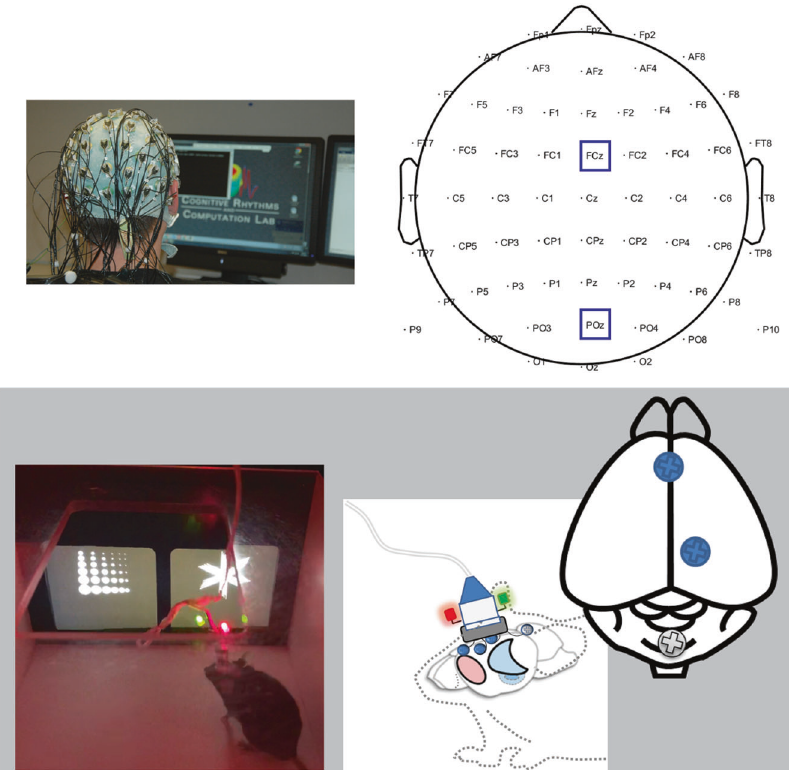
Fig. 1 Schematic electroencephalograph (EEG) recording in humans and mice. The present studies utilized EEG recordings in humans and mice while they performed tasks that probed RDoC-relevant domains of functioning, including effortful motivation, reward learning, and cognitive control. Humans used a joystick to respond to on-screen stimuli, while mice responded using a touchscreen. Scalp (human) and dura (mice) EEG recordings were recorded during the execution of these tasks. Time-frequency regions-of-interest were contrasted between task conditions to compare neural signatures of these RDoC